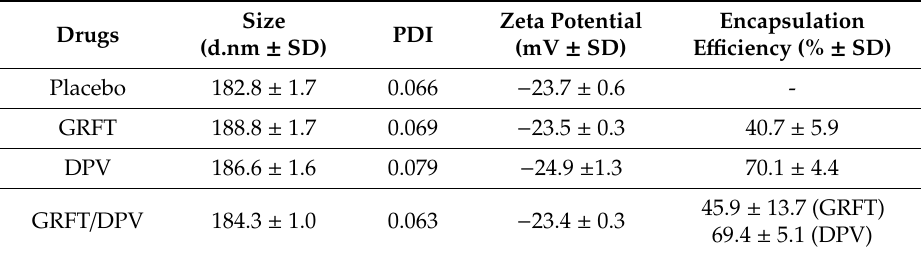
Table 1. Physicochemical properties of PLGA nanoparticles loaded with